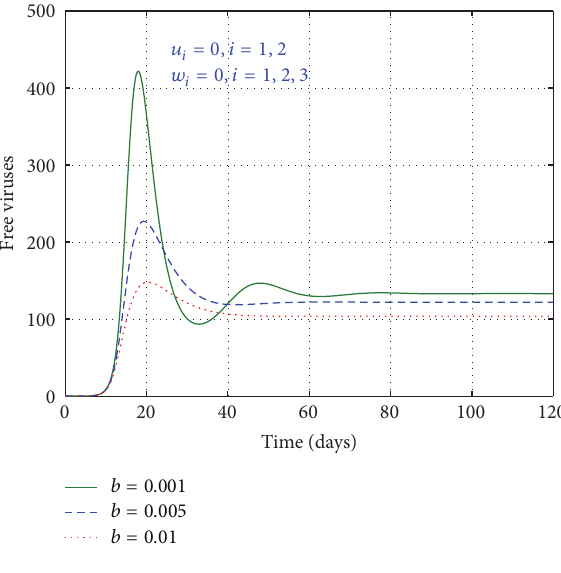
Figure 5: The evolution of infected hepatocytes under MPC.